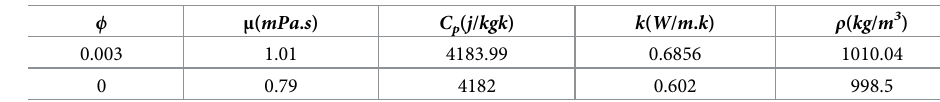
Table 1. Characteristics of hybrid MWCNT–Fe 3 O 4 / water nanofluid [41].